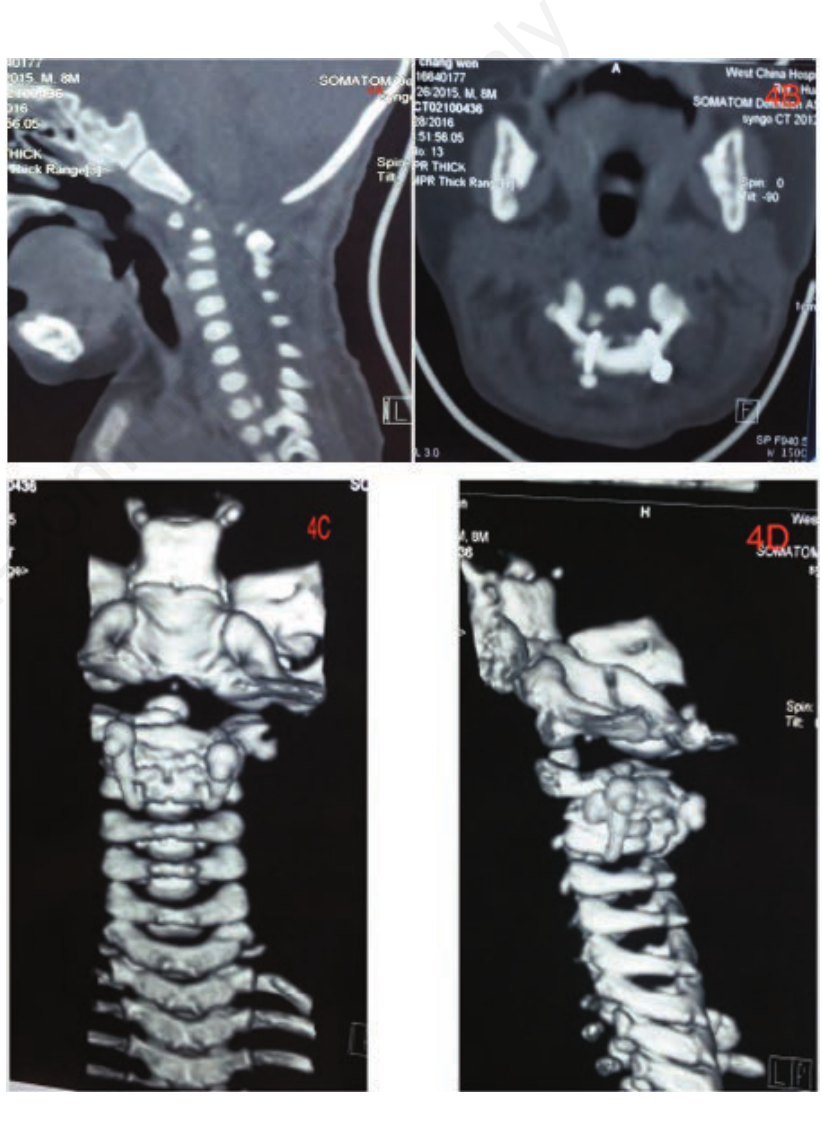
Figure 4. A-B) Are postoperative MRI showing good anatomical reduction; while C-D) are 3D postoperative images also showing good anatomical